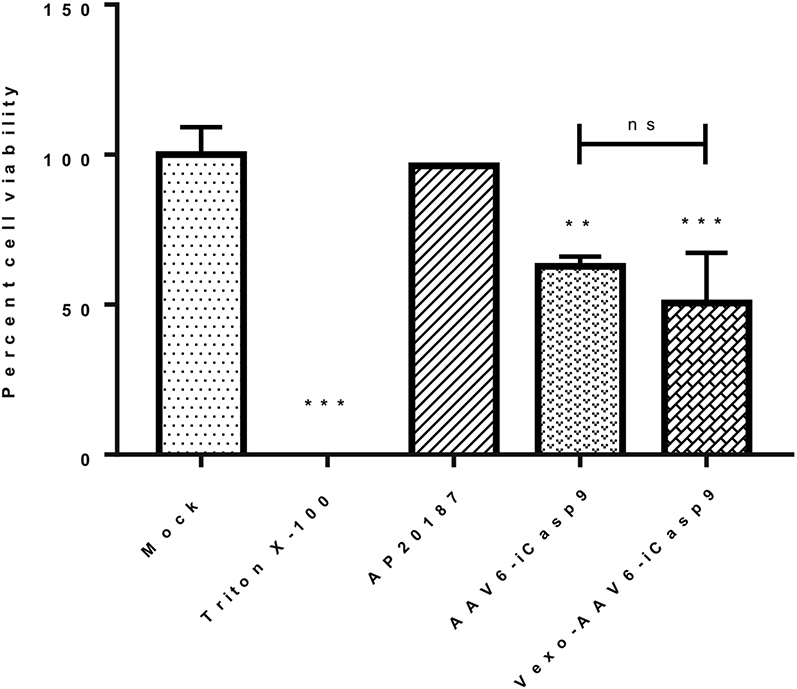
Vexosomes Are Cytotoxic to Hepatocellular Carcinoma, Huh7 Cells In VitroHuh7 cells were infected with either AAV6 or Vexo-AAV6-iCasp9 vectors, at a multiplicity of infection (MOI) of 5 × 104 vgs/cell, followed by treatment with AP20187. The viability of Huh7 cells treated with a combination of vector and dimerizer drug, after 72 h of vector infection, was determined using an ATP assay (Promega) and depicted in comparison to mock-treated cells. Triton X-100, positive control; AP20187, drug-only control. Data are mean ± SD from two independent experiments (n = 3 replicates each condition per experiment, ∗∗p < 0.01, ∗∗∗p < 0.001 in comparison to mock-treated cells). ns, not significant.